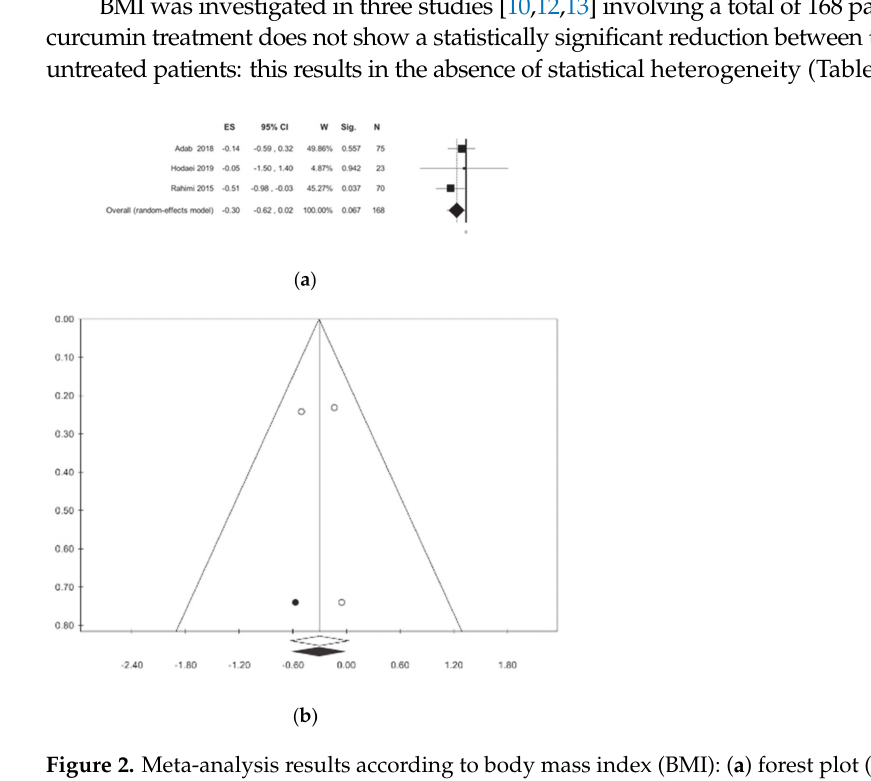
Figure 2. Meta-analysis results according to body mass index (BMI): ( a ) forest plot ( b ) funnel